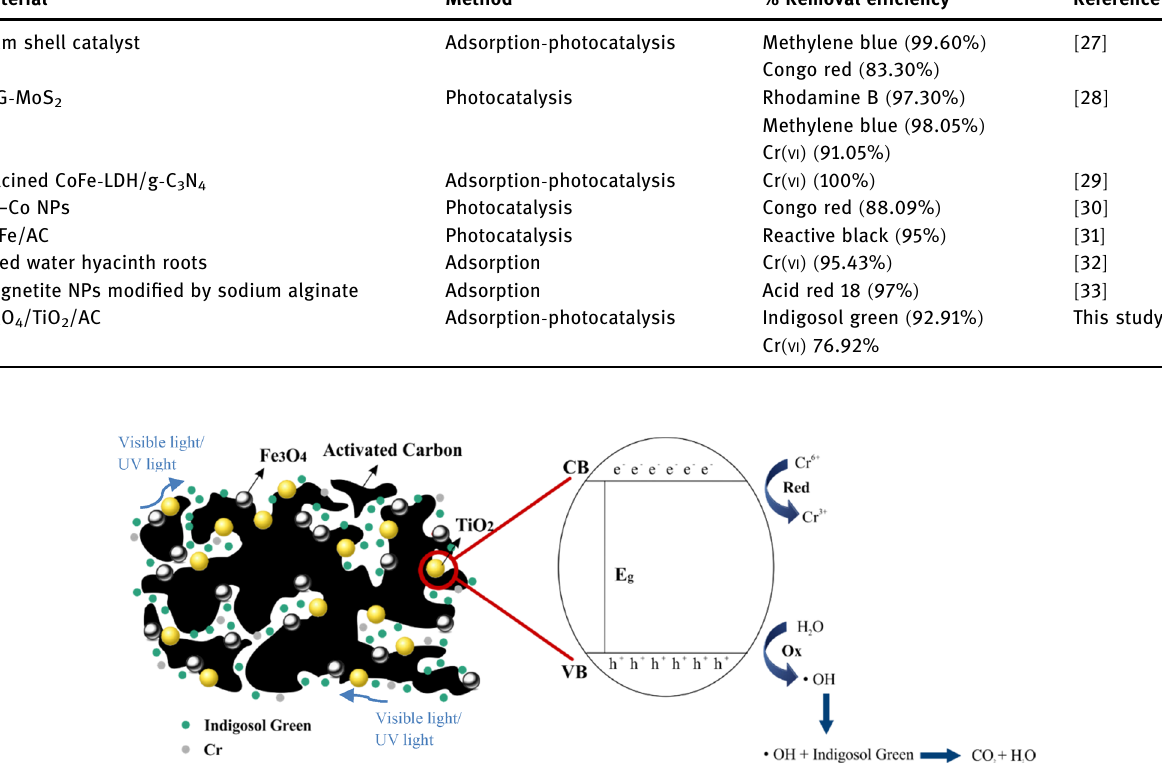
Table 2: Summary of various treatment methods for the removal of dyes and heavy metals from wastewater Material